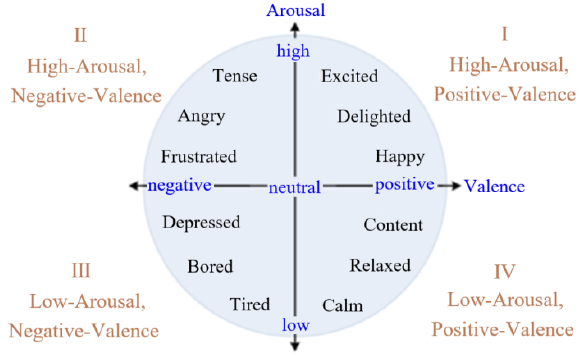
Figure 1. Valence-arousal model.